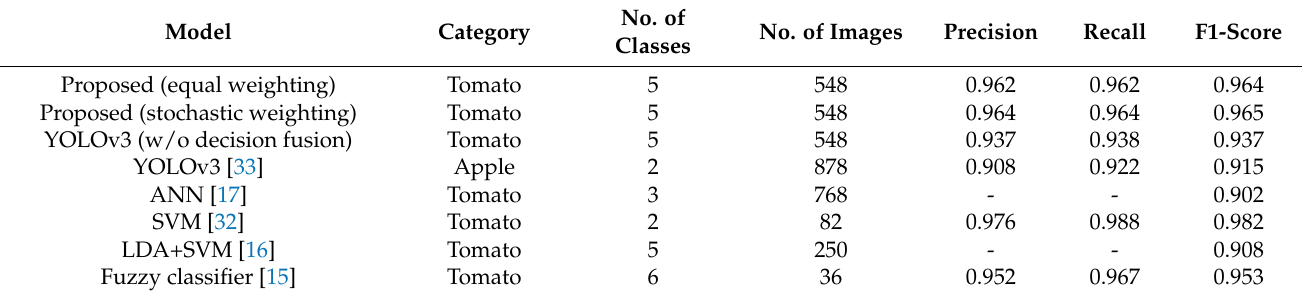
Figure 6. Precision–recall curves for three deep learning models for tomato ripeness detection with the same test dataset: Table 5. Comparison of the detection performance of the SDF-ConvNets to other